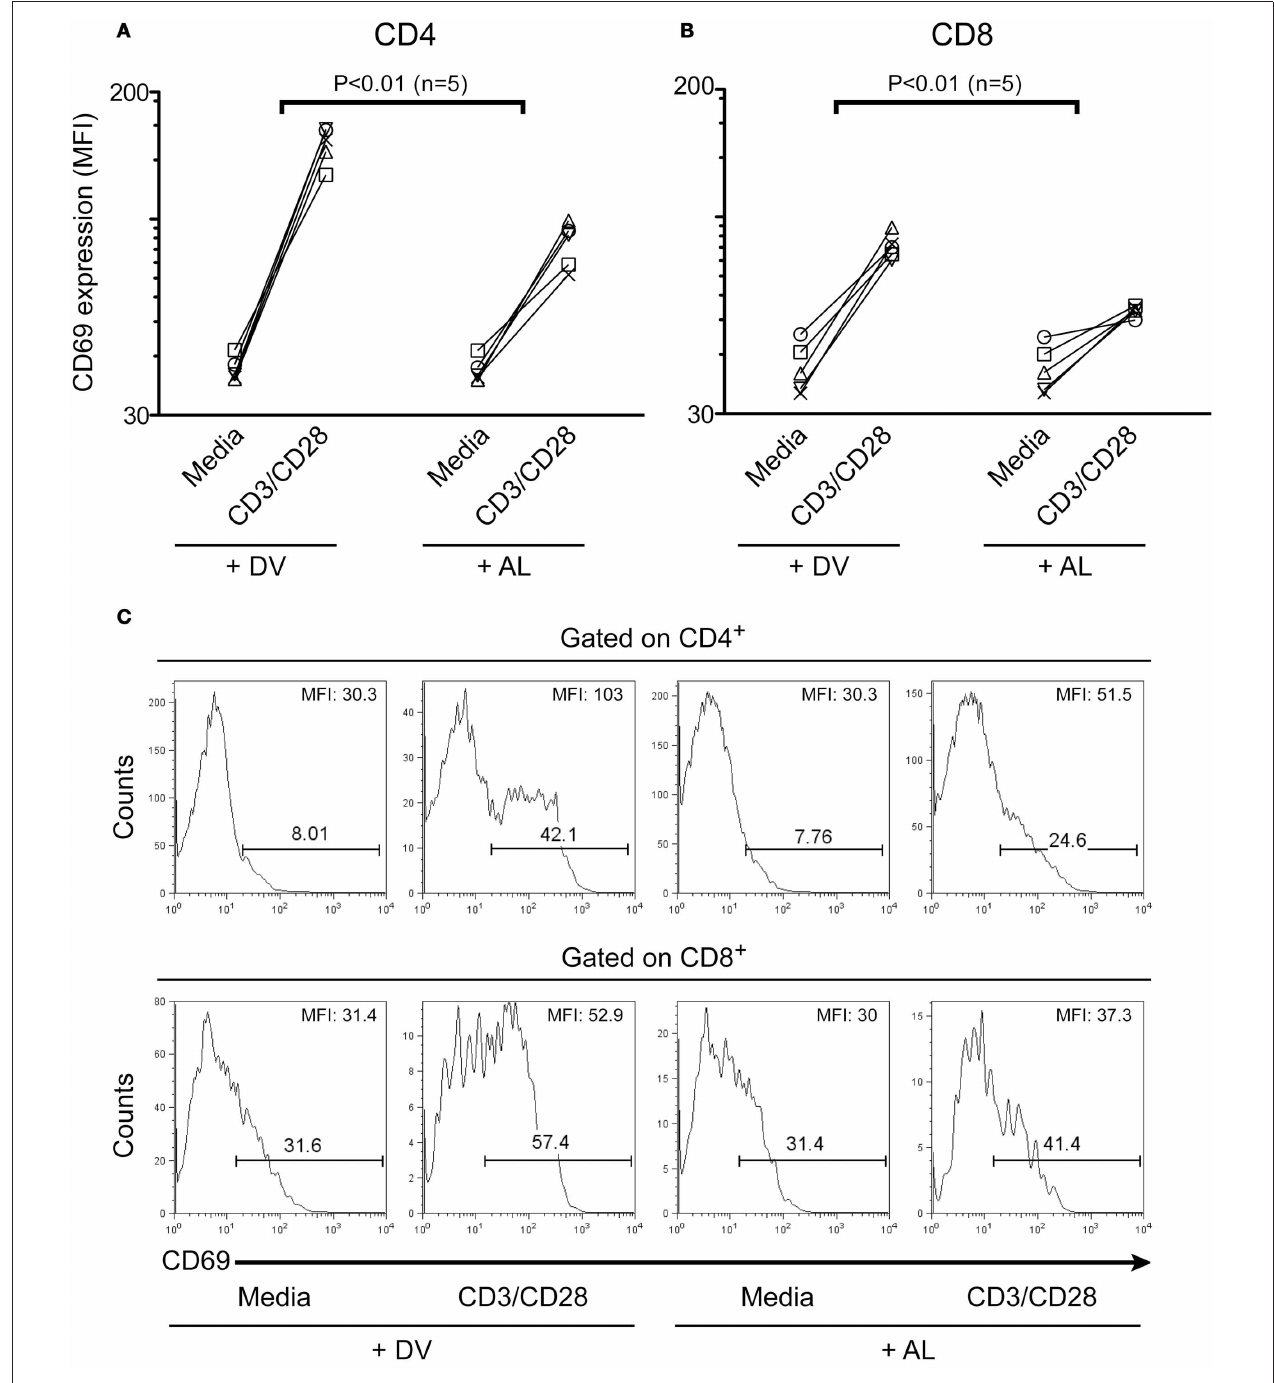
FIGURE 3 | Allopurinolattenuatesactivation-drivenCD69upregulationin CD4 + and CD8 + T cells. PBMC were incubatedfor 5h with mediaor with anti-CD3 (1 μ g/ml) plusanti-CD28 (1 μ g/ml) antibodies,in the presenceof allopurinol( + AL, 300 μ g/ml) or drug vehicle alone ( + DV).Cells werethen stained with anti-CD4(PerCP),anti-CD8(APC) andanti-CD69(PE)andanalyzed with four color flowcytometry. Lymphocyteswere gated byforward and side light scatter. Fromthis populationsingle color CD4 or CD8 staining histogram was made,and the expressionof CD69 was analyzed.Each line showsthe mean fluorescenceintensity (MFI) of CD69expressionon CD4 + (A) or CD8 +